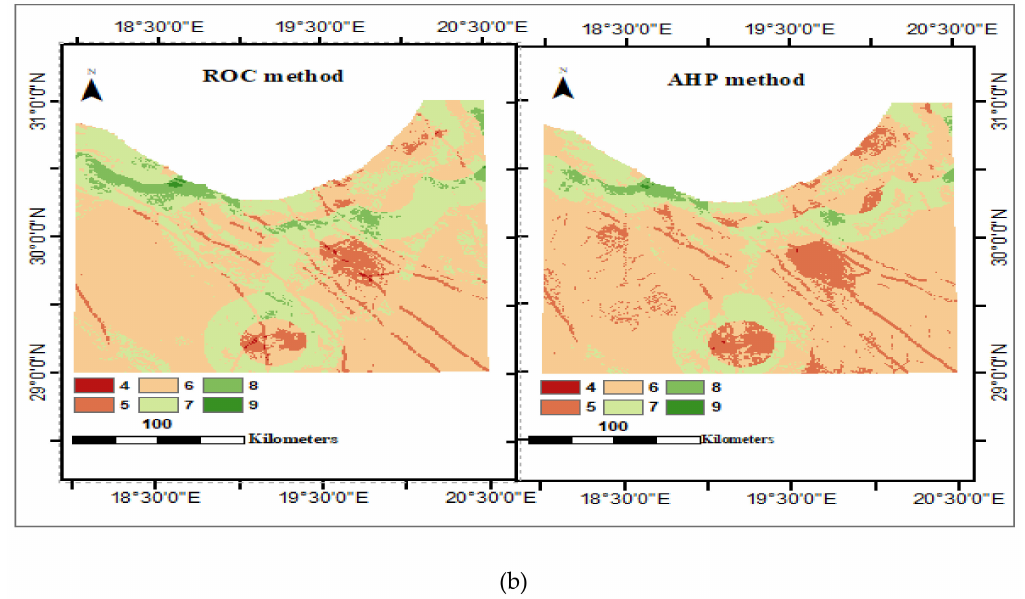
Figure 10. ( a ) Number of pixels and suitability index resulting from the two output maps. ( b ) Output map of AHP and ROC.